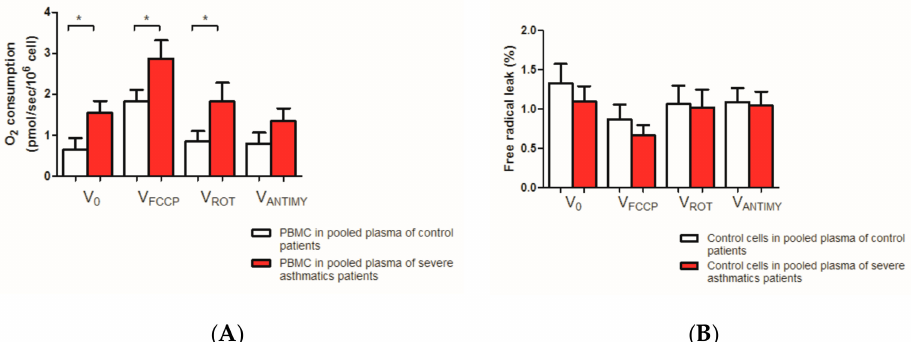
Figure 5. E ff ect of healthy and asthmatic plasma on PBMC mitochondrial respiration and free radical leak. ( A ) Mitochondrial respiration after di ff erent substrates injected. (B) Free radical leak. PBMC: peripheral blood mononuclear cell. FCCP: carbonyl cyanide 4-(trifluoro-methoxy)phenylhydrazone, ROT: rotenone, ANTIMY: antimycin. Results are expressed as means ± SEM. n = 7 per group. * p <